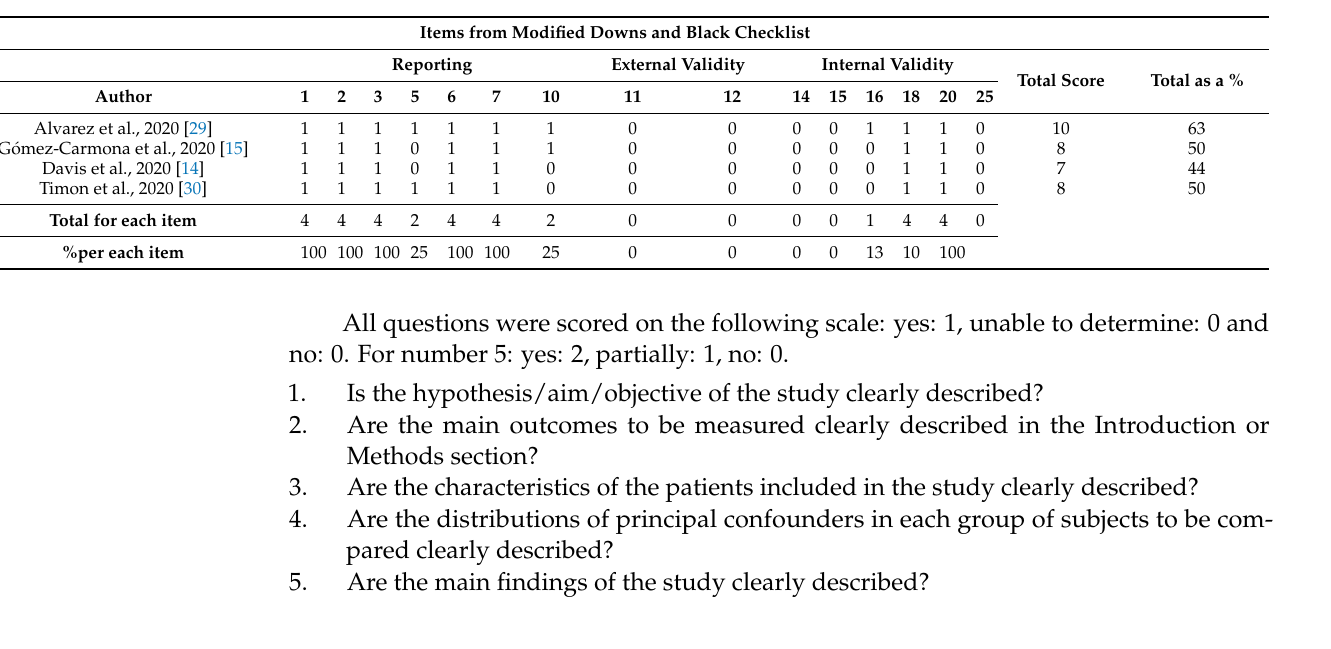
Figure 1. Summary of search strategy and selection process based on included and excluded studies. Table 2. Quality assessment based on modified Downs and Black